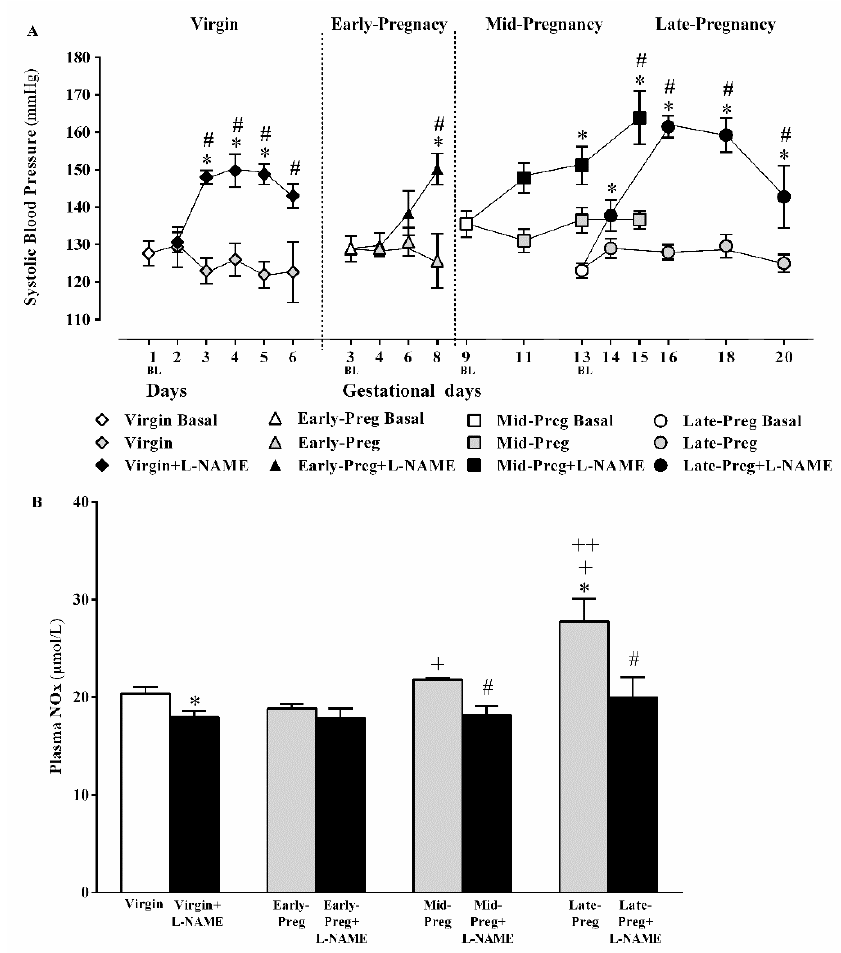
Figure 1. Systolic blood pressure measurements ( A ) and NO bioavailability in plasma ( B ) of virgin rats and Early, middle (Mid) and Late-pregnant rats treated with saline or L-NAME. Values are represented as mean ± SEM. In the panel A, * P < 0.05 versus baseline (BL) of each group and # P < 0.05 versus respective day of each group treated with saline. In the panel B, * P < 0.05 versus Virgin group, # P < 0.05 versus respective Mid-Preg or Late-Preg groups, + P < 0.05 versus Early-Preg or Early-Preg + L-NAME groups, and ++ P < 0.05 versus Mid-Preg or Mid-Preg + L-NAME groups.